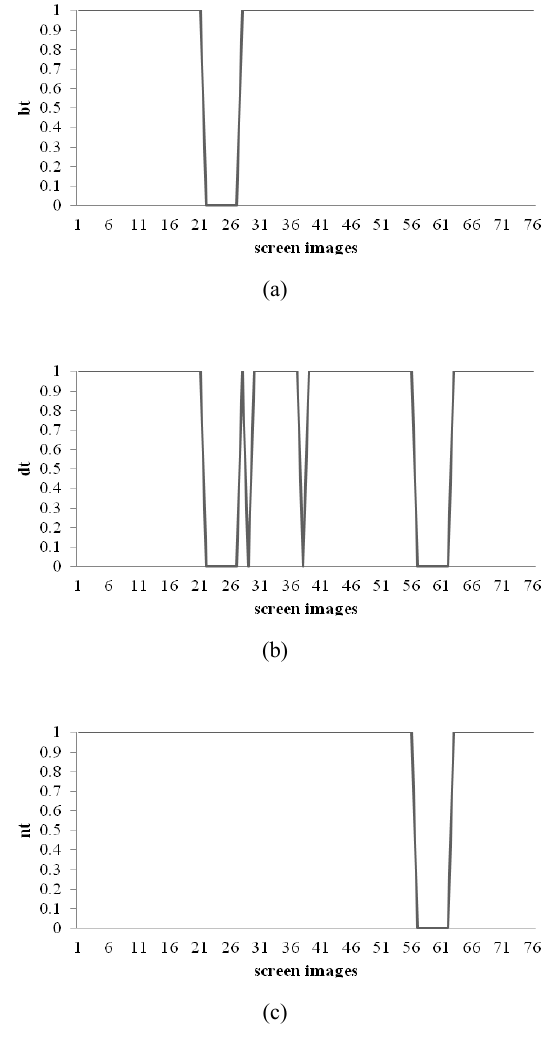
Fig. 5. Practical usage of context recognition for web-based learning systems: (a) web-based learning access history, (b) context recognition data, (c) detection of high and low interest topics from screen